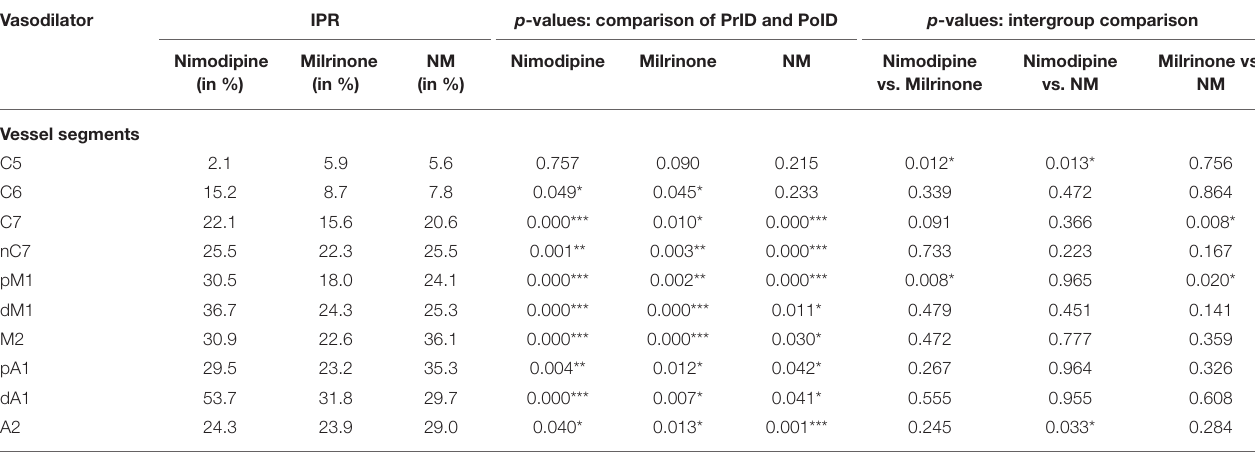
Nimodipine Milrinone vs. vs. Milrinone vs. NM NM